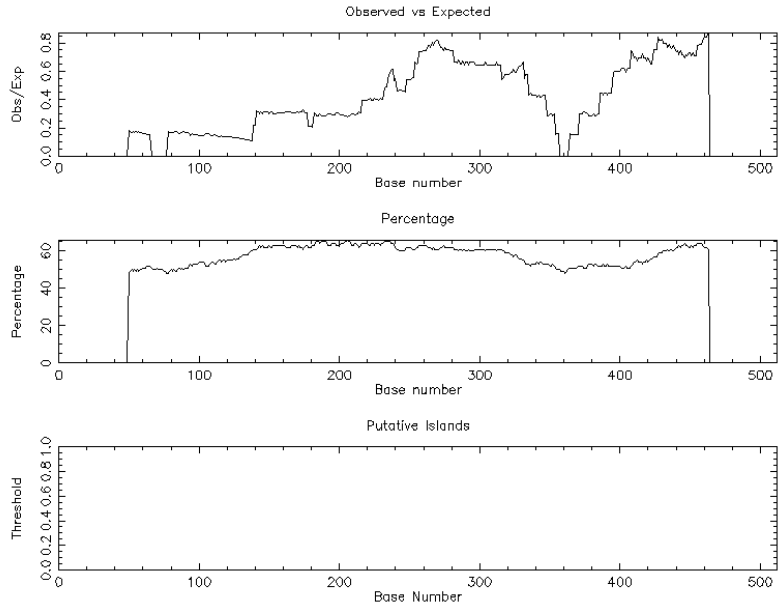
Figure 2. The nucleotide sequential analysis demonstrated one CpG island related to BCL-xL.